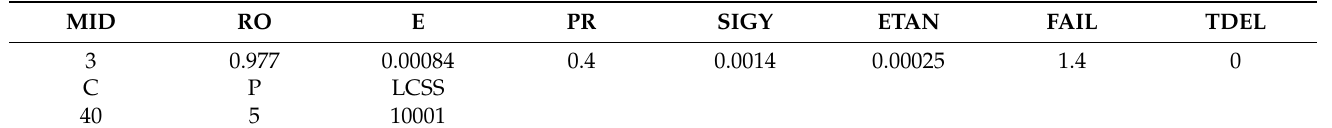
Table 5. Johnson–Holmquist–Cook concrete CARDS. Table 4. MAT_PIECEWISE_LINEAR_PLASTICITY CARDS.